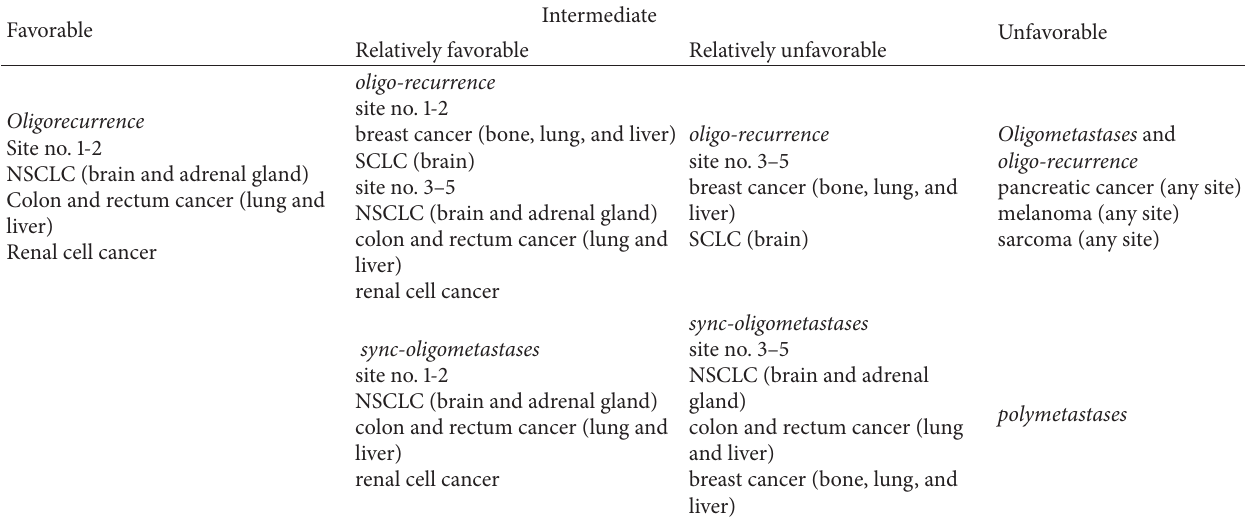
Table 1: Niibe-Onishi-Chang